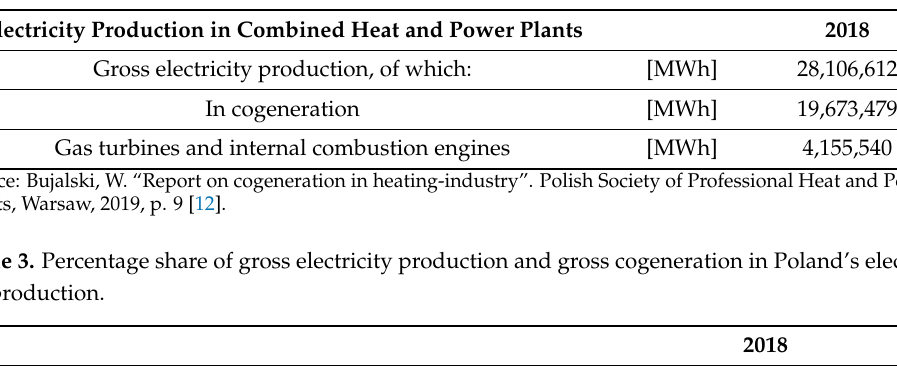
Table 2. Electricity production in combined heat and power plants.